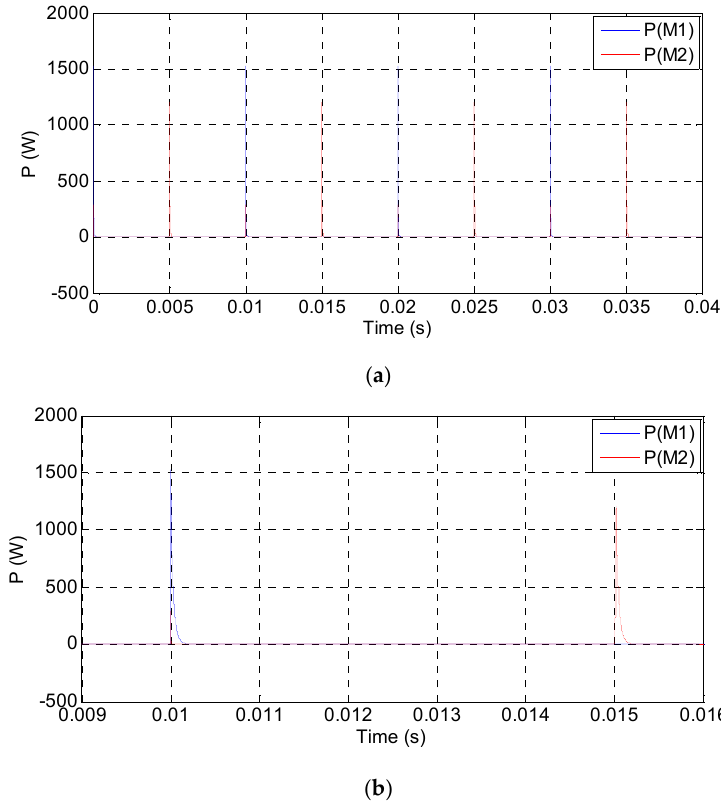
Figure 17. Simulated power consumptions of the MOSFETs: ( a ) the overall perspective waveform and ( b ) the detailed power consumptions of M 1 and M 2.